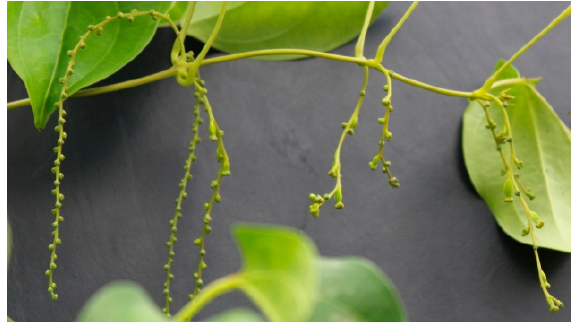
Figure 2. Dioscorea rotundata inflorescences showing ( a ) staminate and pistillate flowers, ( b ) staminate flowers, ( c ) pistillate flowers.